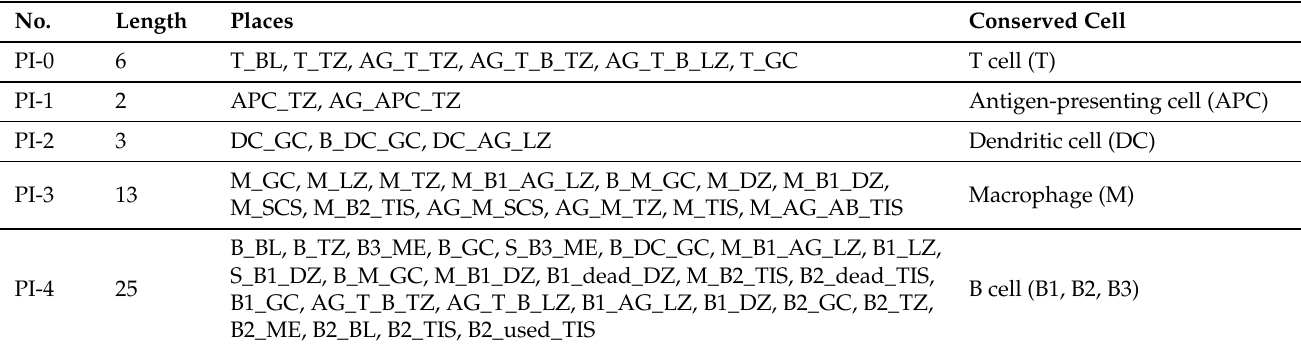
Table A7. List of ten place invariants (PIs) of the place-bordered and ordinary Petri net. The columns with “length”, “places”, and “conserved cell” provide the number of places of the PI, the names of all places of the PI, and the conservation of which cell (type) the PI originates from,